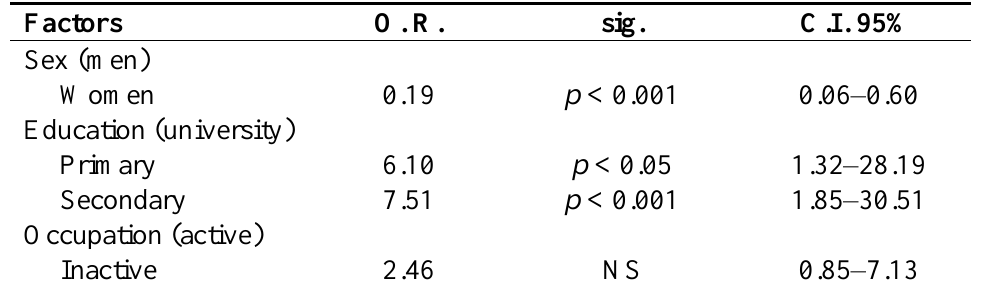
Table 4. Adjusted odds ratio (O.R.) relating the three indicators of unmet needs to selected socio-demographic